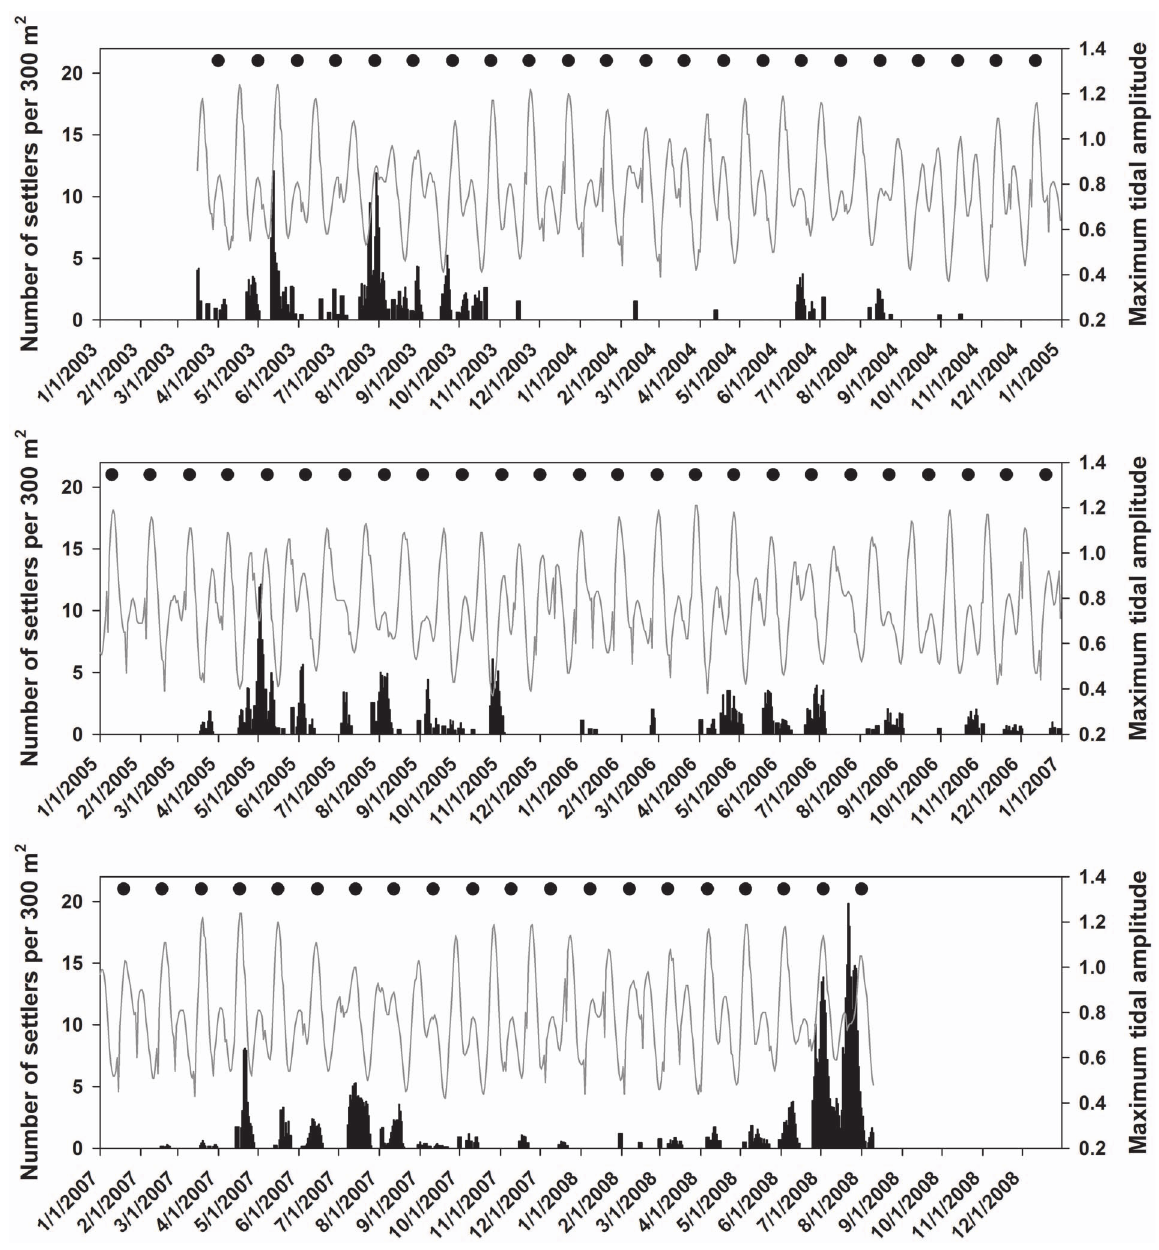
Figure 1. Daily back-calculated settlement of Stegastespartitus in reef and rubble habitat at Pickles and Sand Island Reefs combined (bars). Timing of settlement of collected recruits was adjusted for monthly density estimates and estimated post-settlement mortality. Maximum tidal amplitude is indicated by a line, and new moons by solid circles. Asterisks indicate months when sampling did not take place.